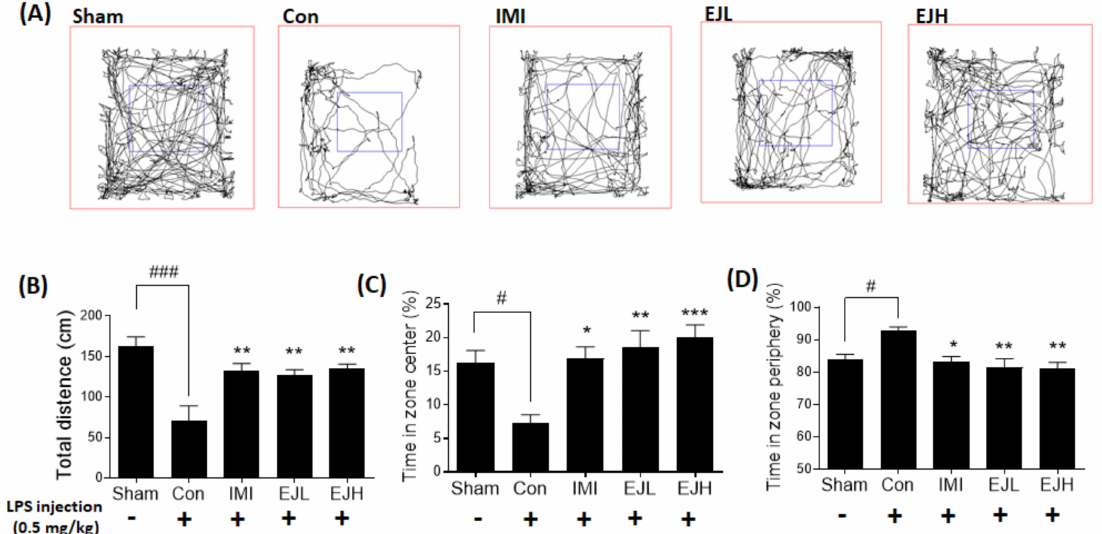
Figure 3. E ff ect of EJE on locomotor activity in LPS-induced depressive mice. The tracing of the locomotion patterns for 5 min ( A ), LPS-injected mice exhibited depressive-like behaviors, while EJ extract led to markedly improved activity; total distance (cm) ( B ), time in zone center (%) ( C ), and time in zone periphery (%) ( D ). Results are presented as mean ± standard error of the mean (SEM). EJE, E. japonicum extract; LPS, lipopolysaccharide; Con, control; EJL, low dosage of EJE; EJH, high dosage of EJE; IMI, imipramine 30 mg / kg; EJL, EJE 100 mg / kg; EJH, EJE 300 mg / kg. *** p < 0.001, ** p < 0.01, * p < 0.05 versus the LPS-injected Con; ### p < 0.001, # p < 0.05, versus the